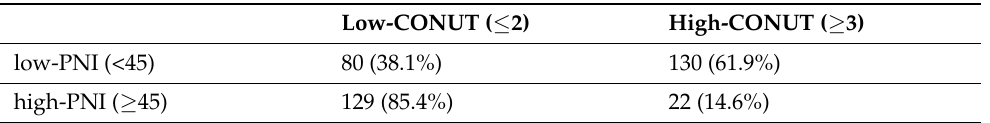
Table 5. Relationship between PNI and CONUT